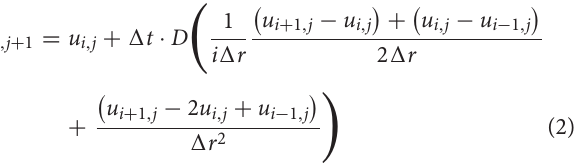
FIGURE 13 | Total outflow (mixture of acetone/water) for three different amounts of acetone vs. time.